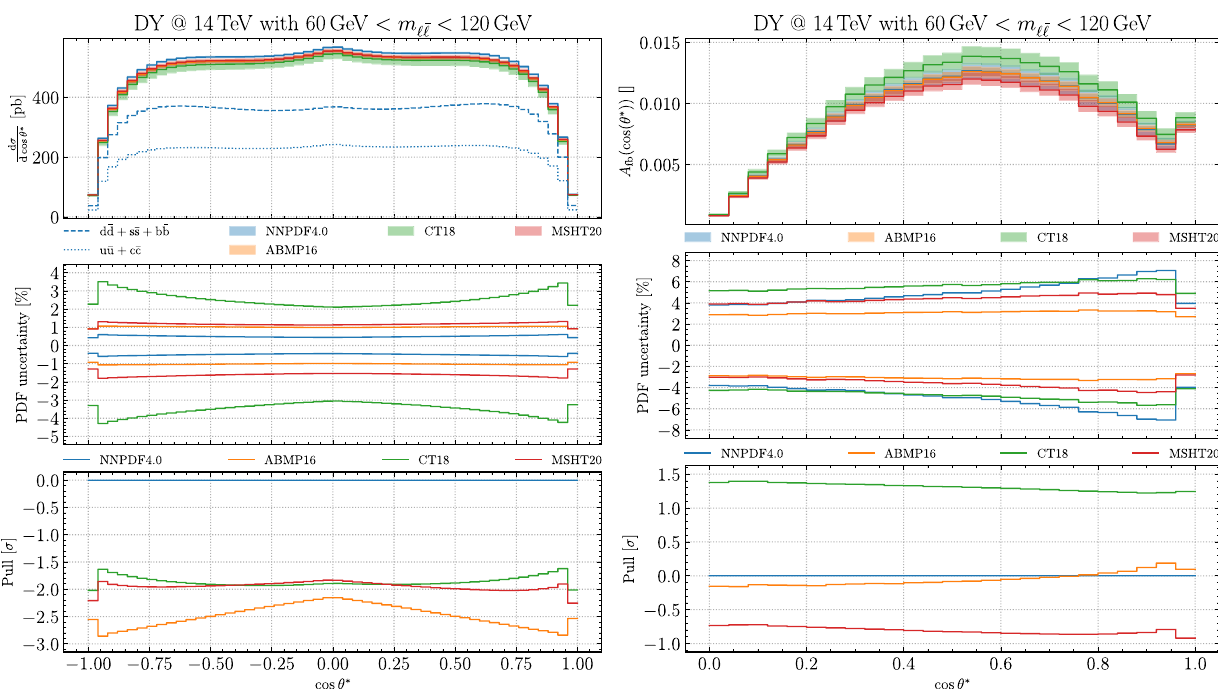
Fig. 18 Same as Fig. 17, now for the differential distribution in cos θ ∗ (left) and the corresponding forward–backward asymmetry A fb ( cos θ ∗ ) (right), in the Z -peak region defined by 60 GeV < m (cid:2) ¯ (cid:2) < 120